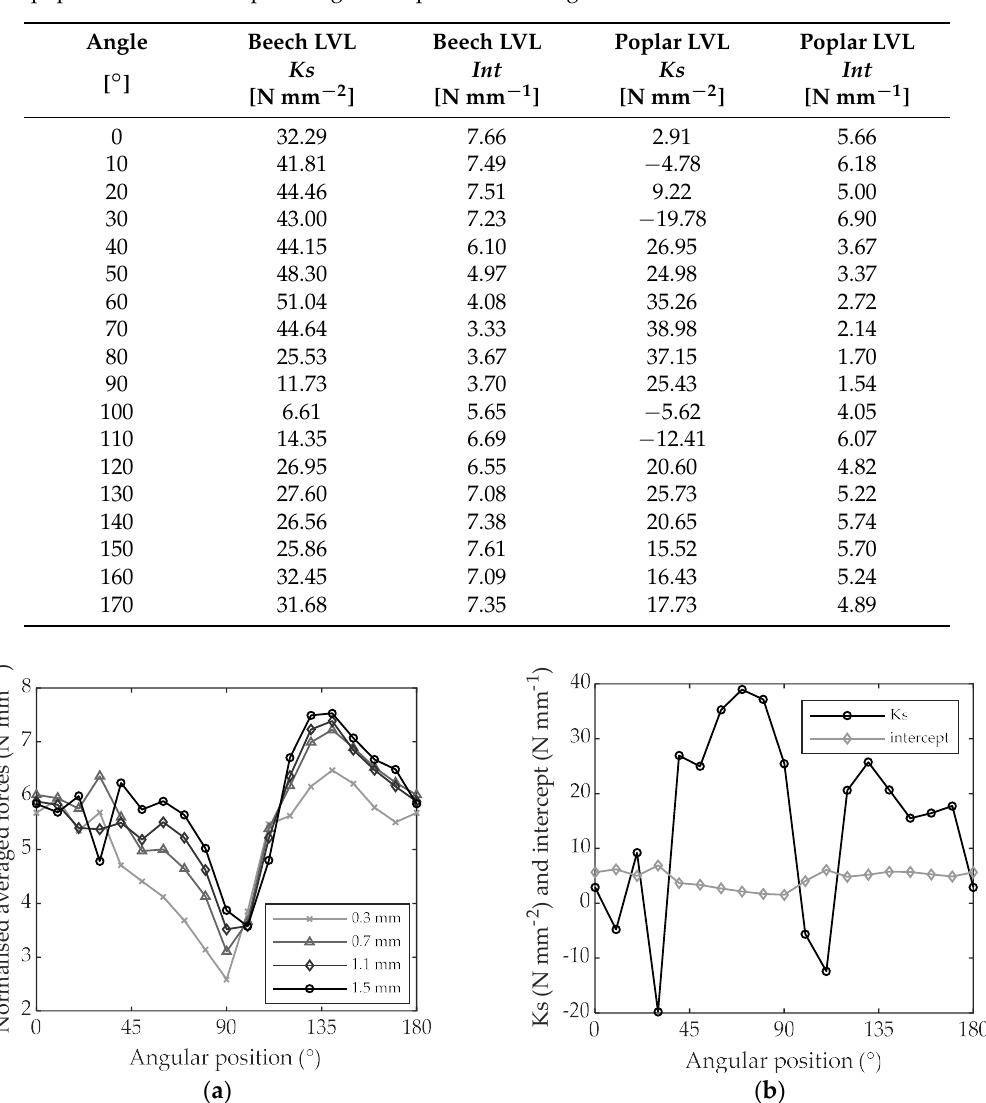
Figure 12. ( a ) Average cutting forces referring to the cutting period versus angular position when Table 4. Specific cutting coefficient ( Ks ) and intercept values computed when machining beech LVL machining beech LVL with 0.3, 0.7, 1.1 and 1.5 mm of depth of cut; ( b ) intercept and specific cutting coefficient gathered every 10° of angular position.